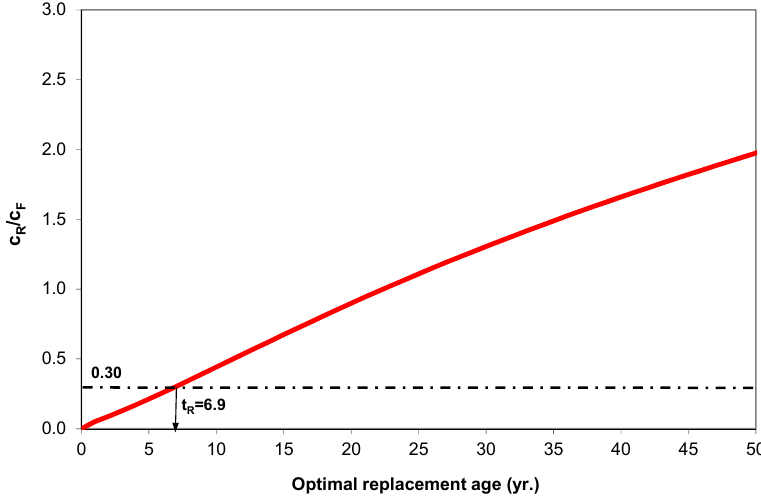
Figure 9. Age replacement policy based for replacement/failure cost ratio = 0.30.